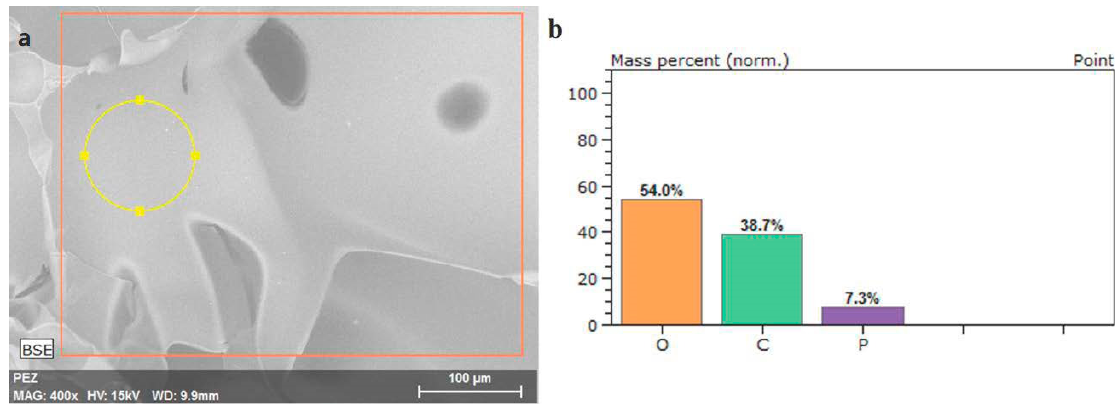
Figure 8. ( a ) SEM analysis and ( b ) EDX analysis of sample